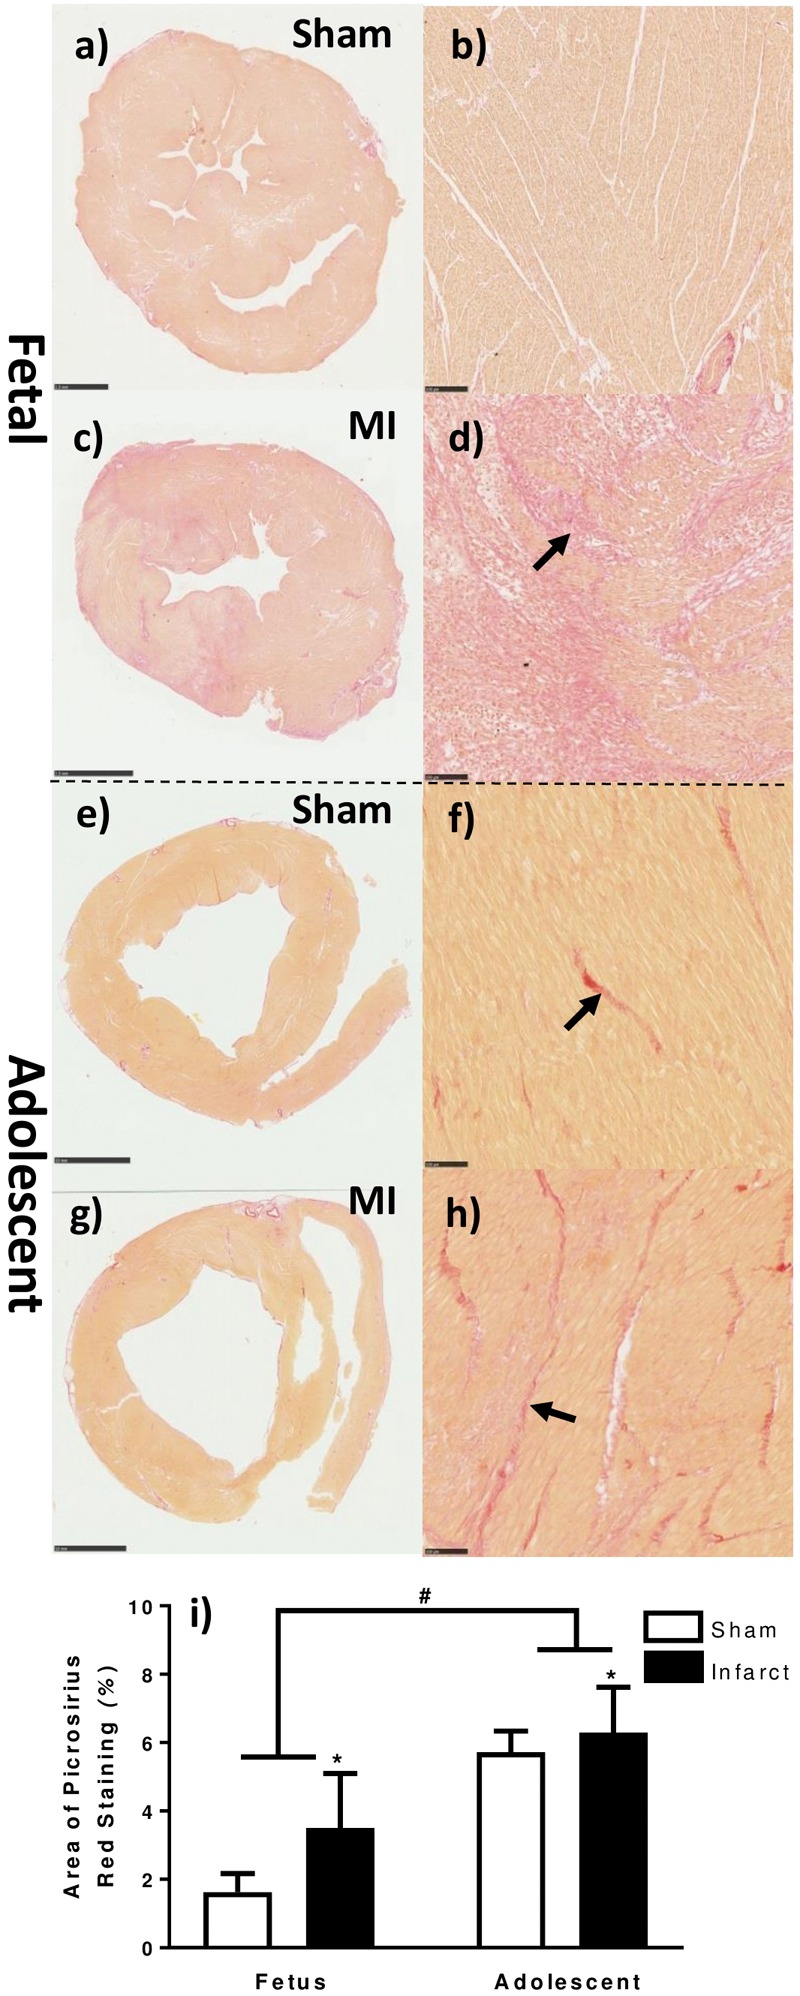
Quantification of collagen staining in the fetal and adolescent heart three days after infarction. (a) Whole fetal heart section sham. (b) 10× magnification representative micrograph fetal sham. (c) Whole fetal heart section MI. (d) 10× magnification representative micrograph fetal MI. (e) Whole adolescent heart section sham. (f) 10× magnification representative micrograph adolescent sham. (g) Whole adolescent heart section MI. (h) 10× magnification representative micrograph adolescent MI. (i) Area of picrosirius red staining in heart tissue sections ± standard deviation. ∗represents significant difference as result of treatment (P < 0.05). #represents significant difference as a result of age (P < 0.05). Analysis was performed using a 2-way ANOVA for treatment group and age (fetuses n = 5 per group, adolescent n = 5 per group). Scale bars of fetal whole sections = 2.5 mm. Scale bars of adolescent whole sections = 10 mm. Scale bars of micrographs = 100 μm. Arrows demonstrate representative picrosirius red staining.